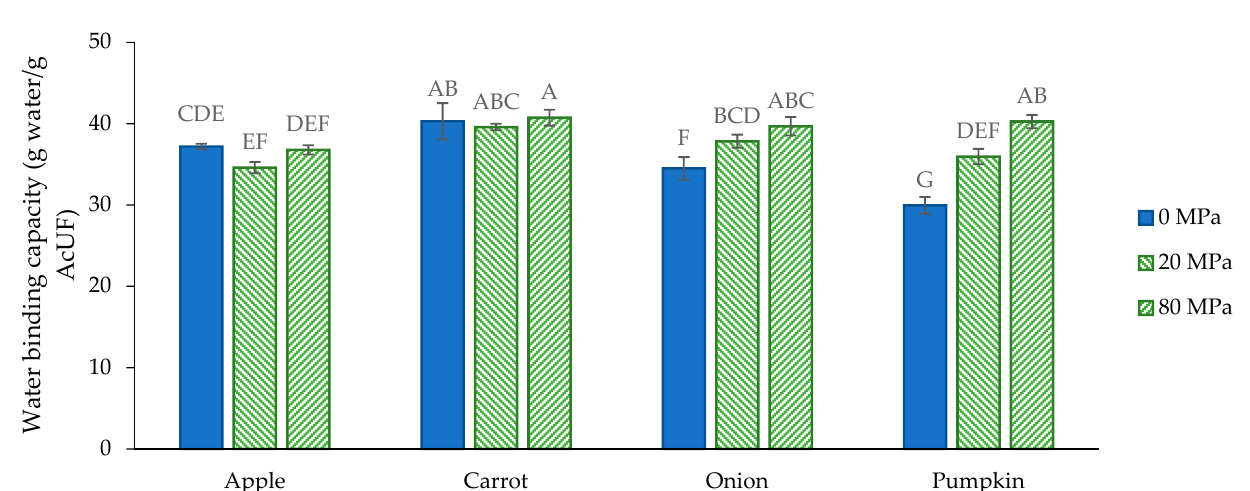
Figure 7. Water binding capacity (2% w / w ) of the acid-unextractable fraction of apple, carrot, onion and pumpkin before (0 MPa) and after high-pressure homogenization at 20 and 80 MPa. The error bars represent the standard deviation (n = 2 × 2) and significant differences are indicated by different letters (Tukey test, p < 0.05).